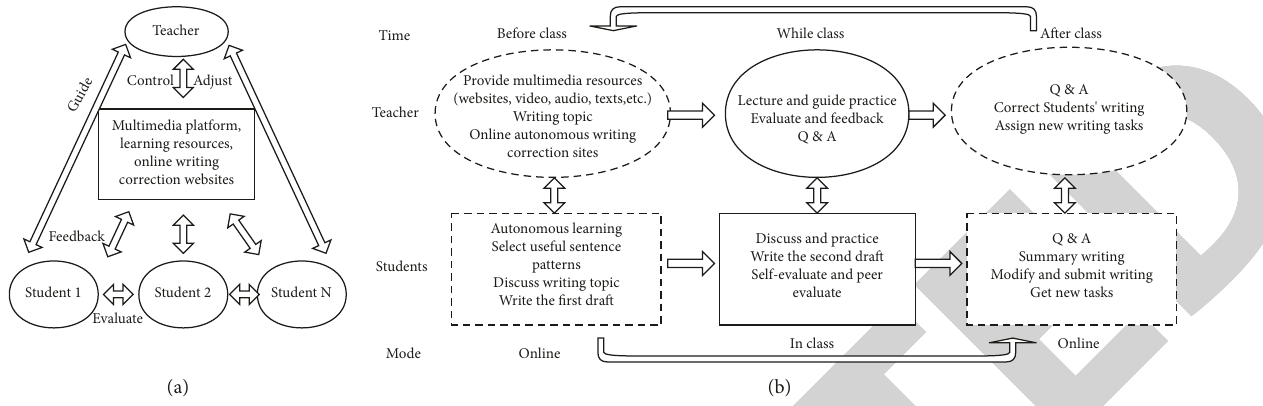
Figure 9: Multimedia writing teaching model. (a) Writing model in the first semester. (b) Modified writing model in the second semester.